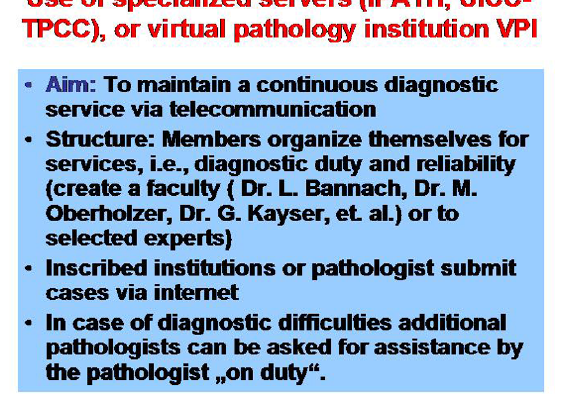
Figure 5 Survey of organization of a virtual pathology institution (VPI) .